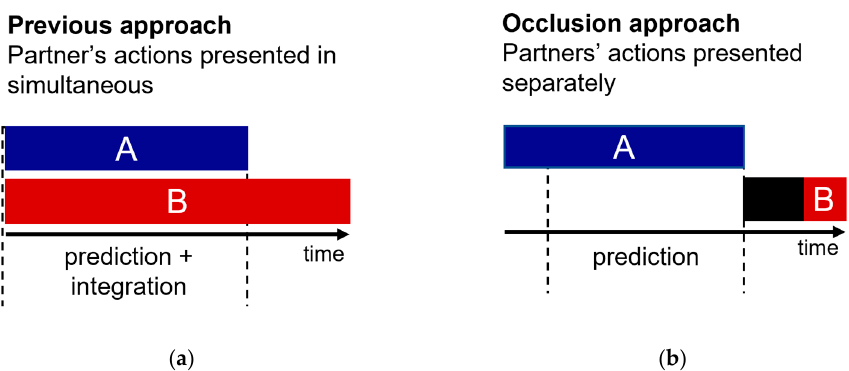
Figure 1. Illustration of the distinction between the experimental approach in previous literature and the occlusion approach used in this study. A and B blocks represent the presentation of each actor. ( a ) In previous studies [3–6], partners’ actions were presented simultaneously. Although one of the actors was masked, there was still the possibility that observers integrate the cues from both actors rather than proactively predicting one actor from the actions of the other; ( b ) in the current study, we separated the presentation of partner’s actions in time. This allowed us to avoid action integration confounds.